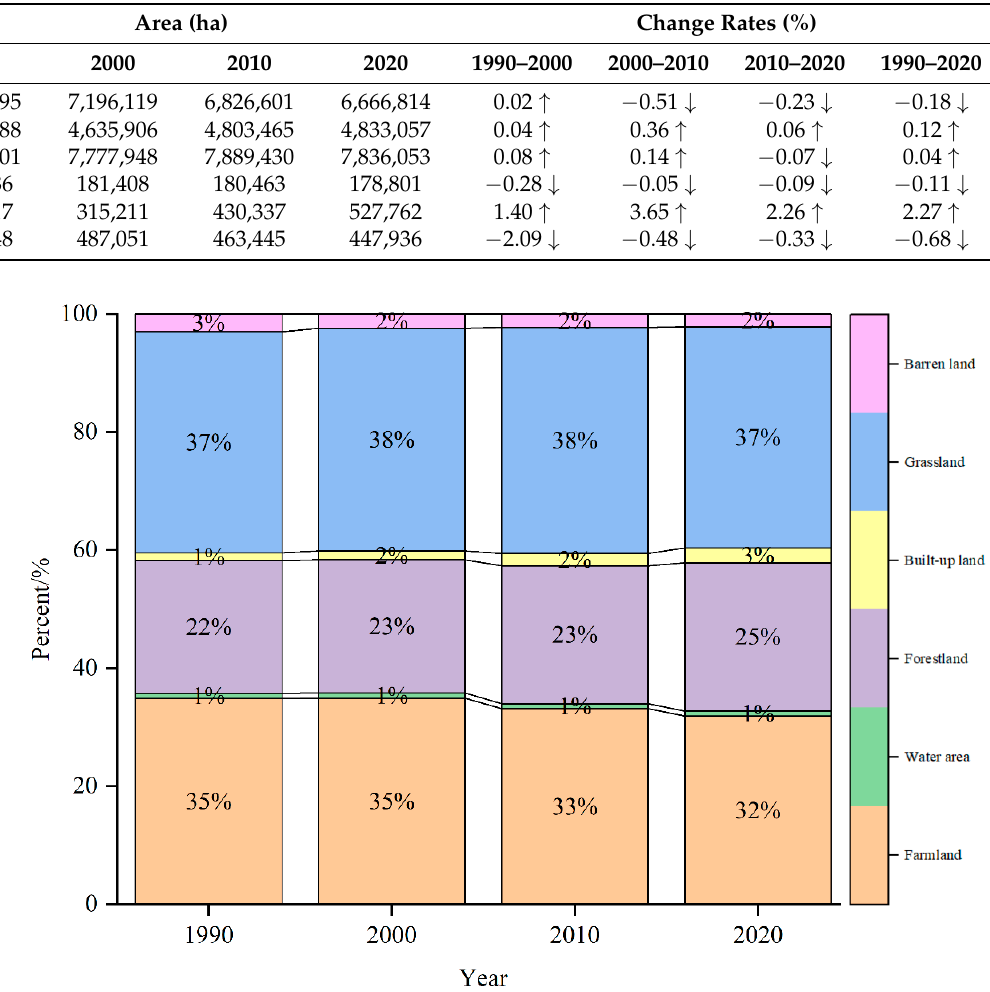
Table 2. Land-use change in Shaanxi Province from 1990 to 2020.